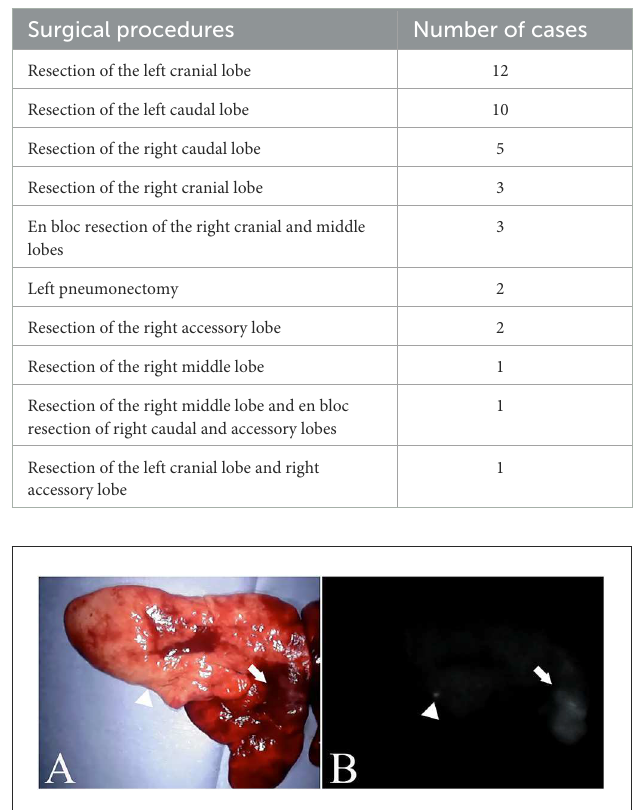
TABLE 1 Breeds of cases. TABLE 2 Surgical procedures for lung